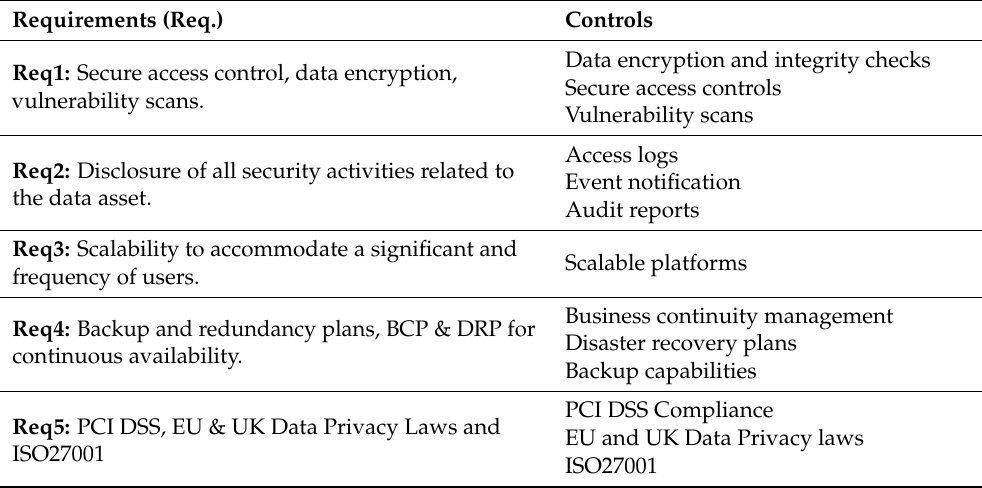
Table 2. List of